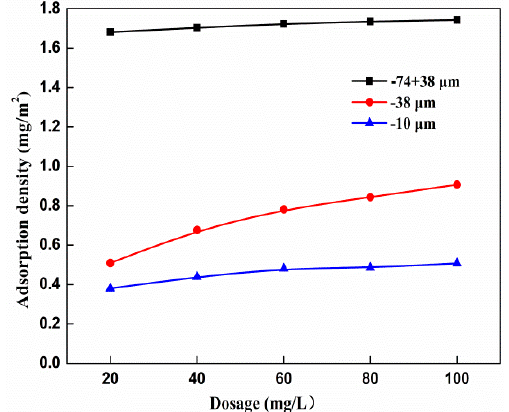
Figure 8. Depressant FPY adsorption results at pH 6.5 for the three size fractions of talc.